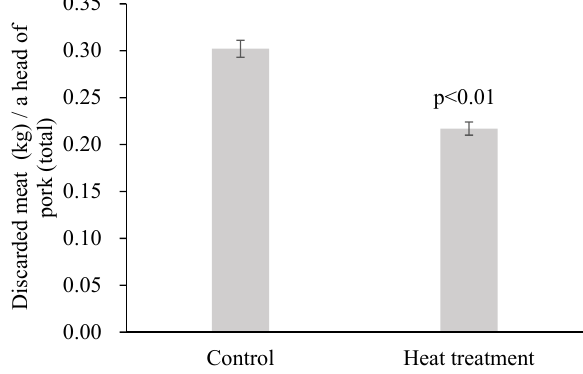
Figure 3. Amount of discarded meat (kg) per a head of total pigs injected with foot-and-mouth disease vaccine after heat treatment at 40°C for 20 min. Error bars are standard error.